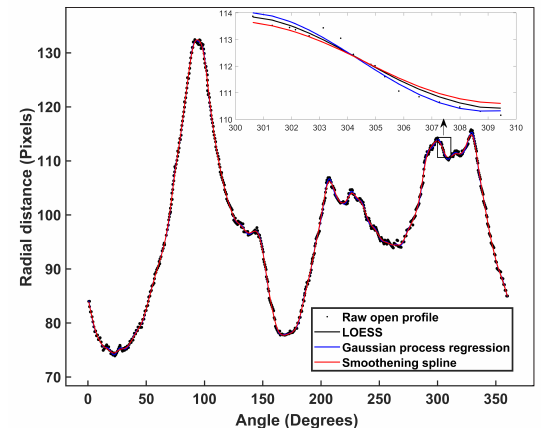
Figure 2: Smoothed open profile